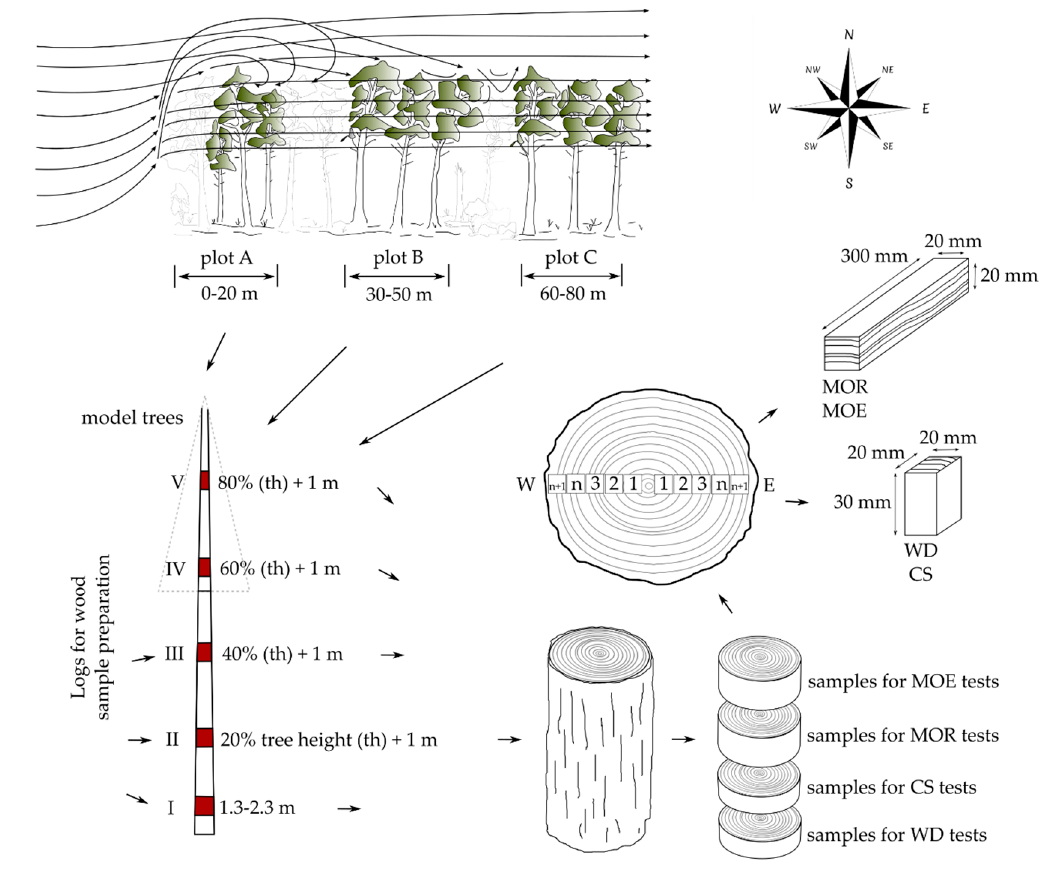
Figure 2. Location plots in stand and sampling procedure. Table 2. Numbers of model trees, logs, and